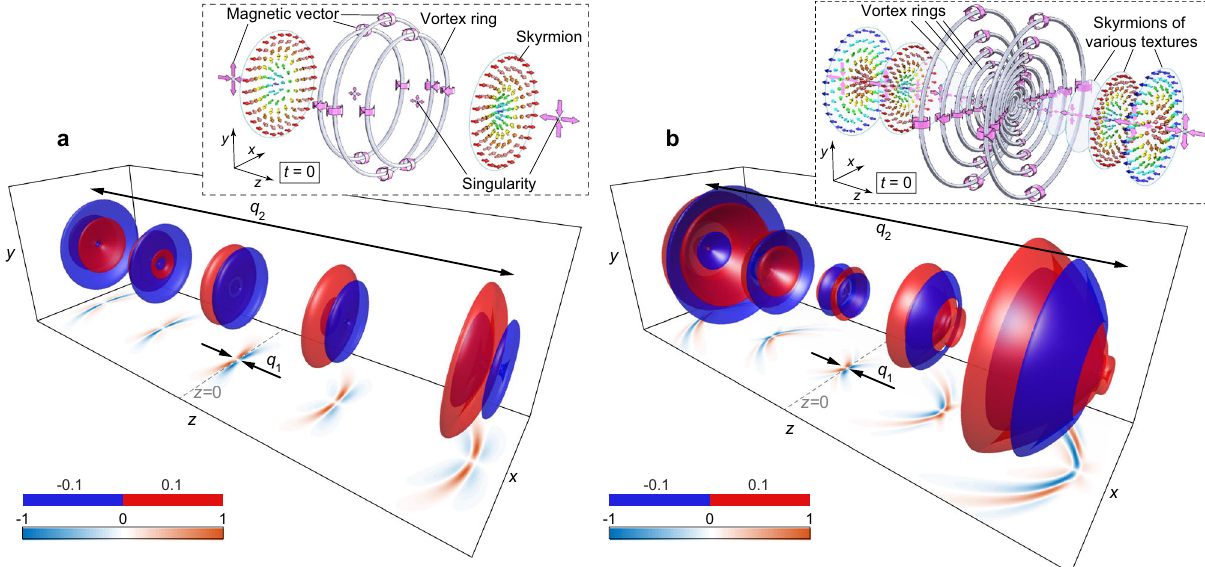
Fig. 1 From toroidal to supertoroidal light pulses. a , b Isosurfaces for the electric fi elds of a the fundamental TLP Re[ E θ ( r , t )], and b a STLP Re ½ E ð α Þ θ ð r ; t Þ(cid:3) of α = 5, at amplitude levels of E = ±0.1 and the Rayleigh range of q instantaneous electric fi eld at y = 0. The insets in ( a ) and ( b ) are schematics of spatial topological structures of magnetic vector fi elds at focus ( t = 0) for the fundamental TLP and STLP, respectively. The gray dots and rings mark the distribution of singularities (saddle points and vortex rings) in magnetic fi eld, large pink arrows mark selective magnetic vector directions, and the smaller colored arrows show the skyrmionic structures in magnetic fi Supplementary Video 3 for the evolution of TLP and STLP with different focused degrees versus values of q 2 / q 1 .